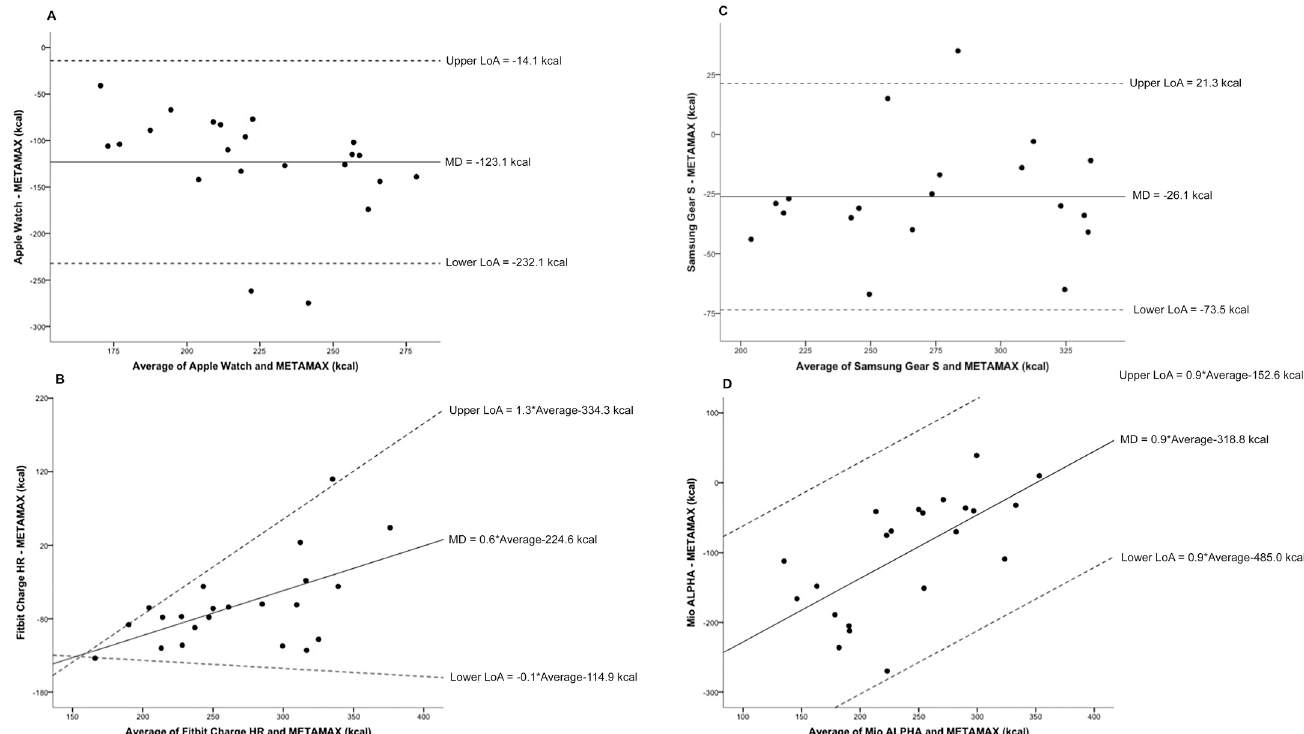
Fig 4. Bland-Altman plots for device [(A) Apple Watch; N = 22, (B) Fitbit Charge HR; N = 22, (C) Samsung Gear S; N = 19, (D) Mio ALPHA; N = 22] and METAMAX (reference) total energy expenditure (kcal). The solid line represents the mean difference (kcal) between the two measures and the dashed lines are the 95% limits of agreement (kcal). Notes : kcal = kilocalories, LoA = limits of agreement, MD = mean difference.